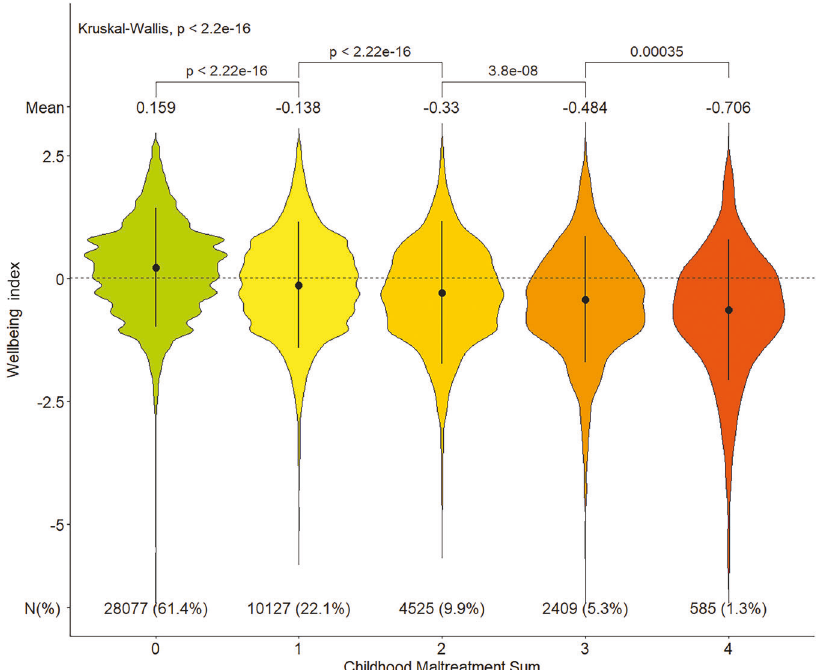
Fig. 5 The impact of multiple childhood maltreatment exposure on the wellbeing index. The x-axis shows the childhood maltreatment sum score which represents number of childhood traumas in each group (0 = no trauma, 4 = experienced all four types of traumas). The y-axis is the wellbeing index z -score. The mean of wellbeing index z-score for each group is shown above each violin plot. The mean difference in wellbeing index between all categories was examined using Kruskal – Wallis test ( p < 2.2 × 10 − 16 ). The pairwise mean difference between two adjacent groups employed the Wilcoxon test and the p -values are presented. The interquartile range is represented by vertical black lines inside the violin plots, and the dotted horizontal line is the median wellbeing index score in the sample ( n = 45,723). The number of participants in each group is shown at the bottom of each